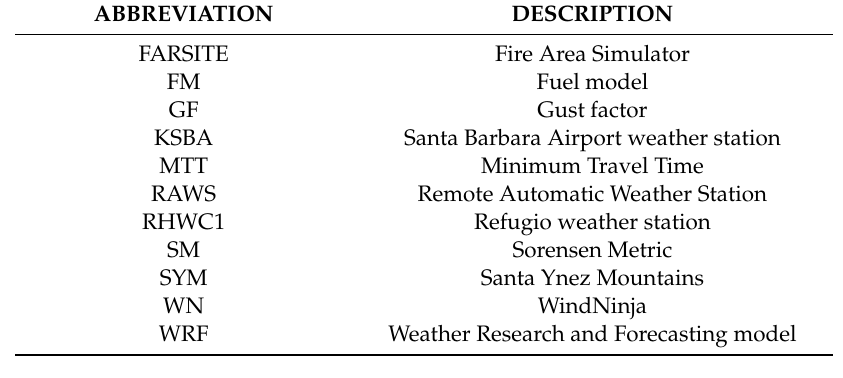
Table A1. Descriptions of all abbreviations used in the manuscript.